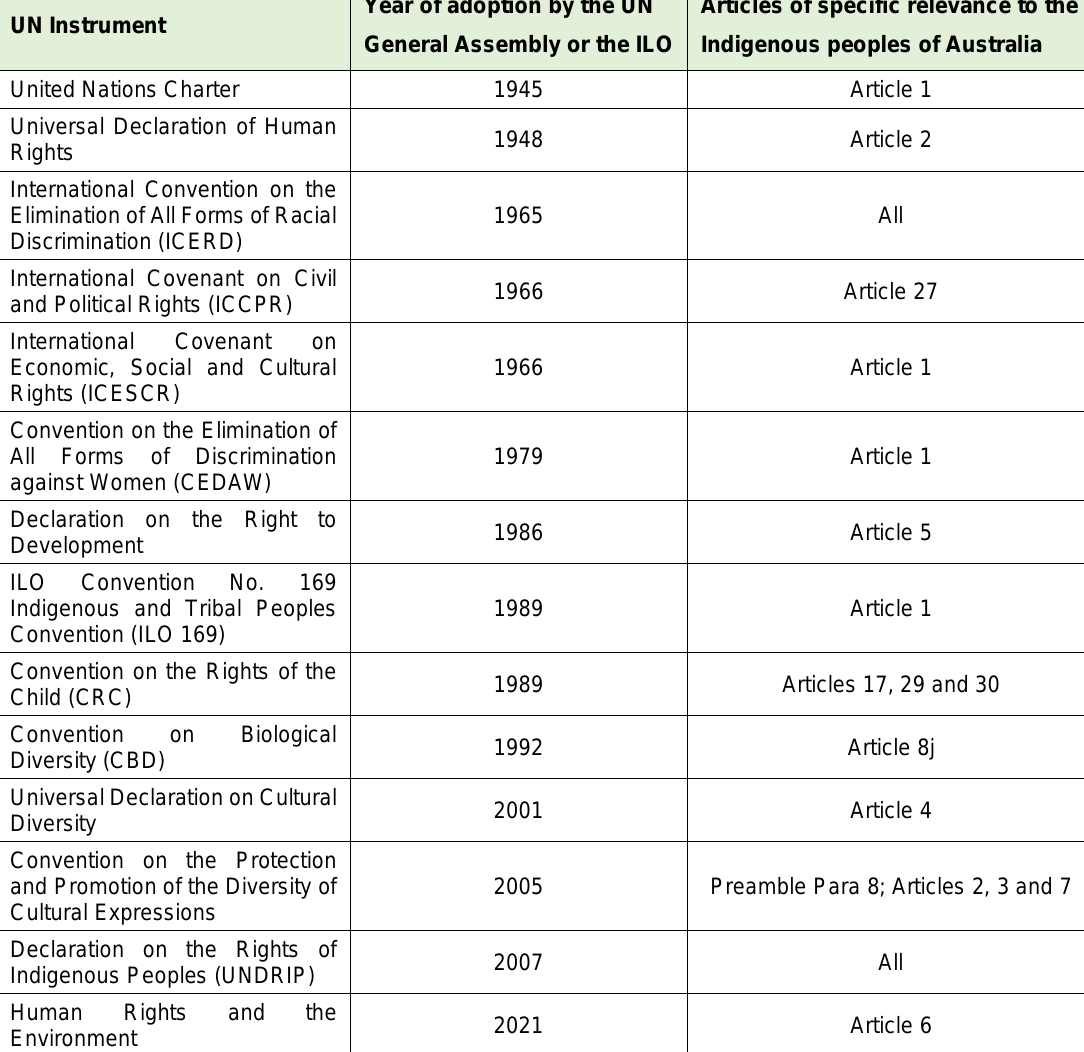
Table 1: International Instruments and Articles of relevance to the Indigenous peoples of